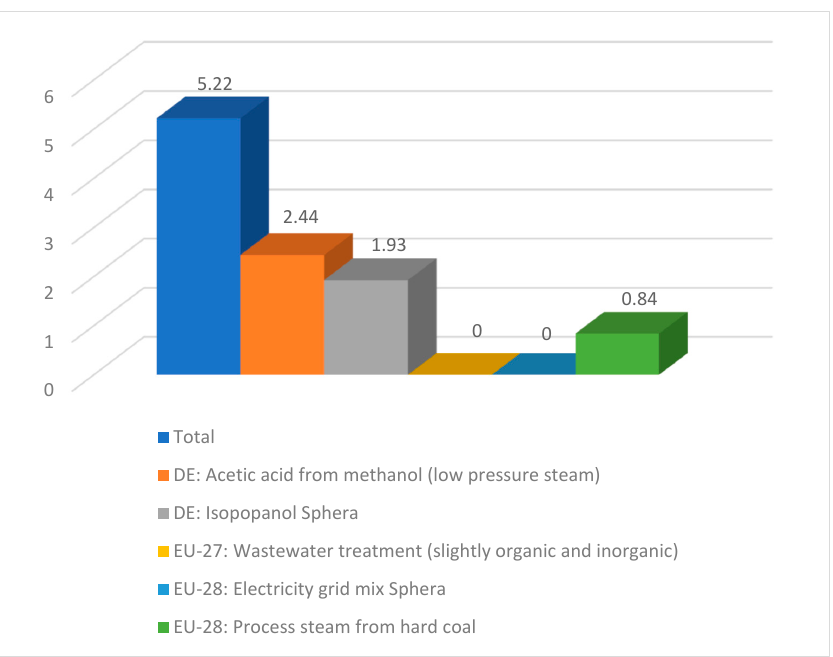
Figure 9. Details about climate change indicator for ( a ) sub-process 4.1 and ( b ) sub-process 5.1.